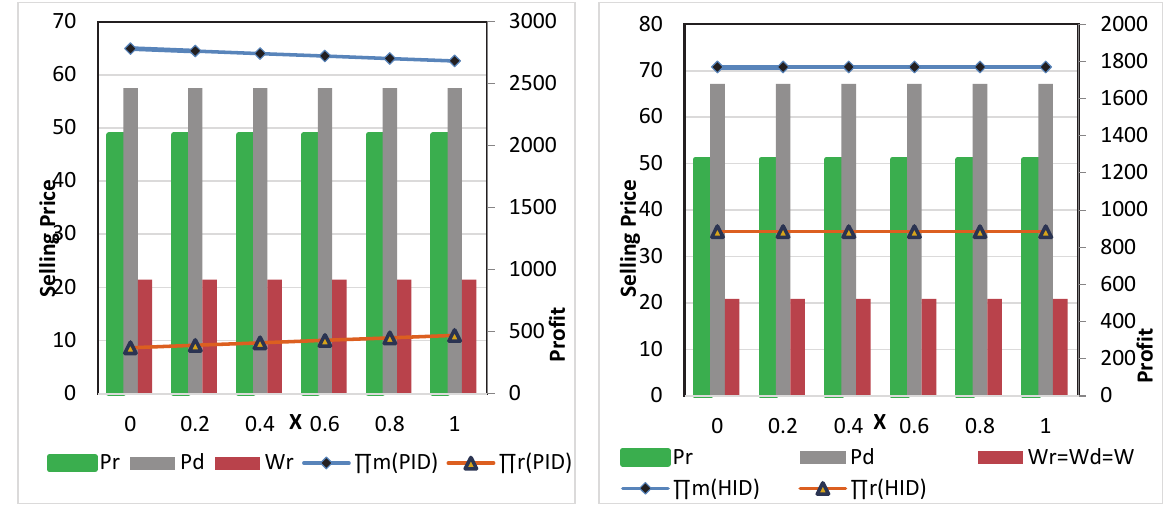
Fig. 1. (c) π r (PID-SC) , π m (PID-SC), P r , P d and W r v/s X Fig. 1. (d) π r/d(HID-SC) , π m (HID-SC) , P r , P d and W r v/s